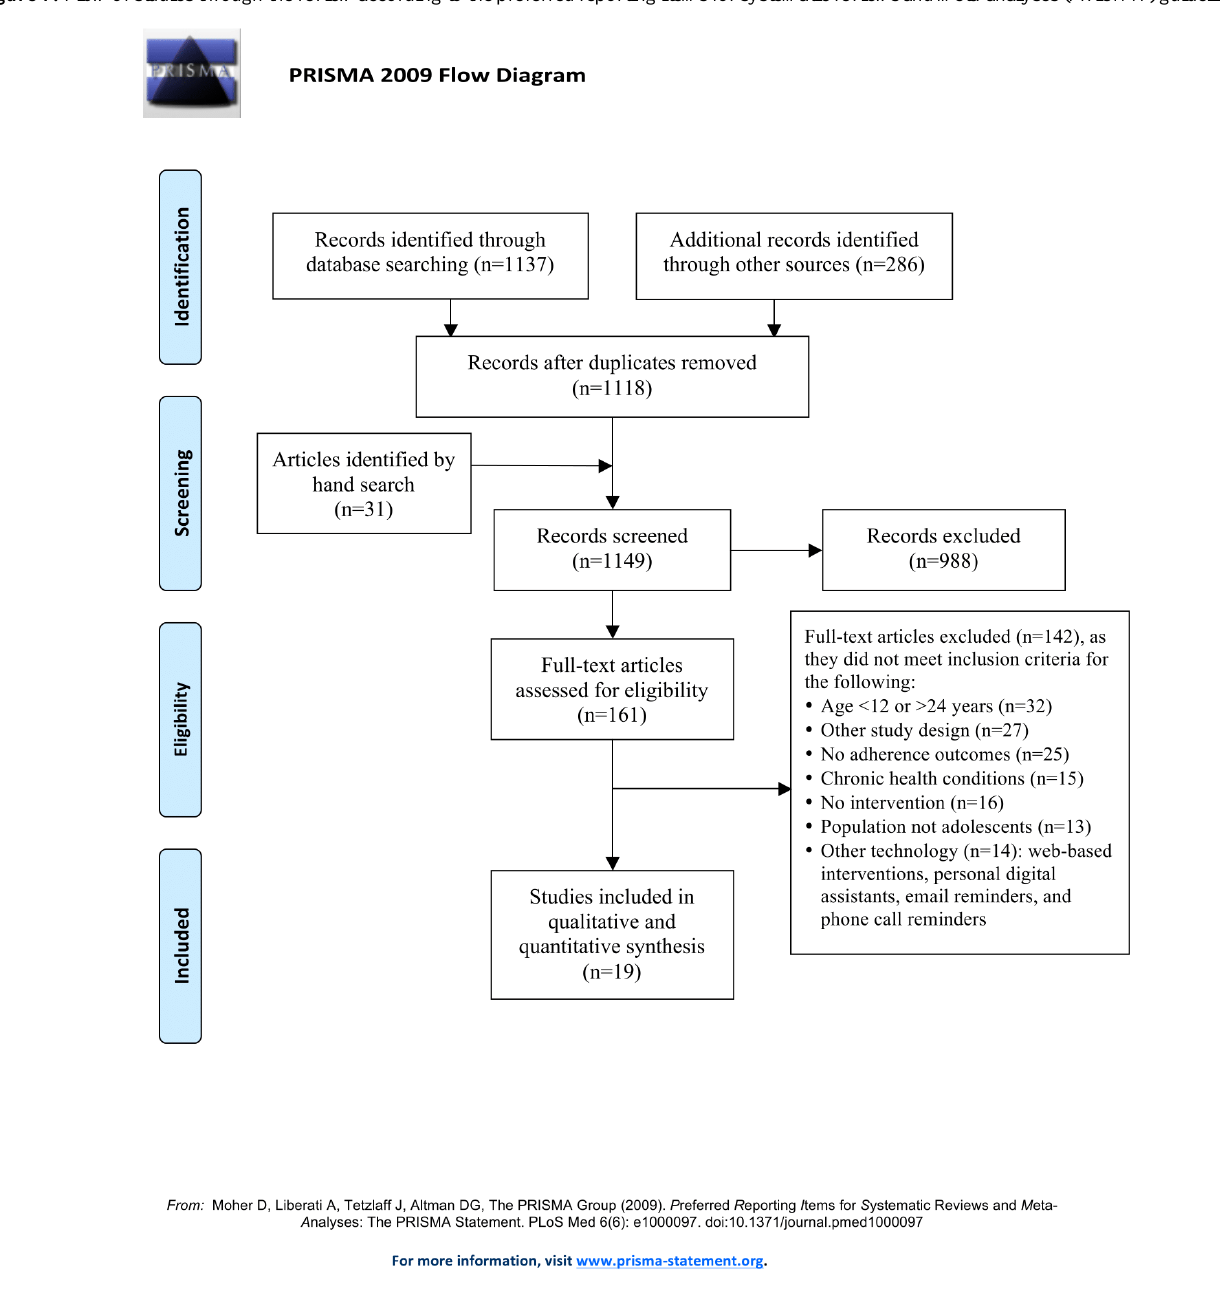
Figure 1. Flow of studies through the review according to the preferred reporting items for systematic reviews and meta-analyses (PRISMA)